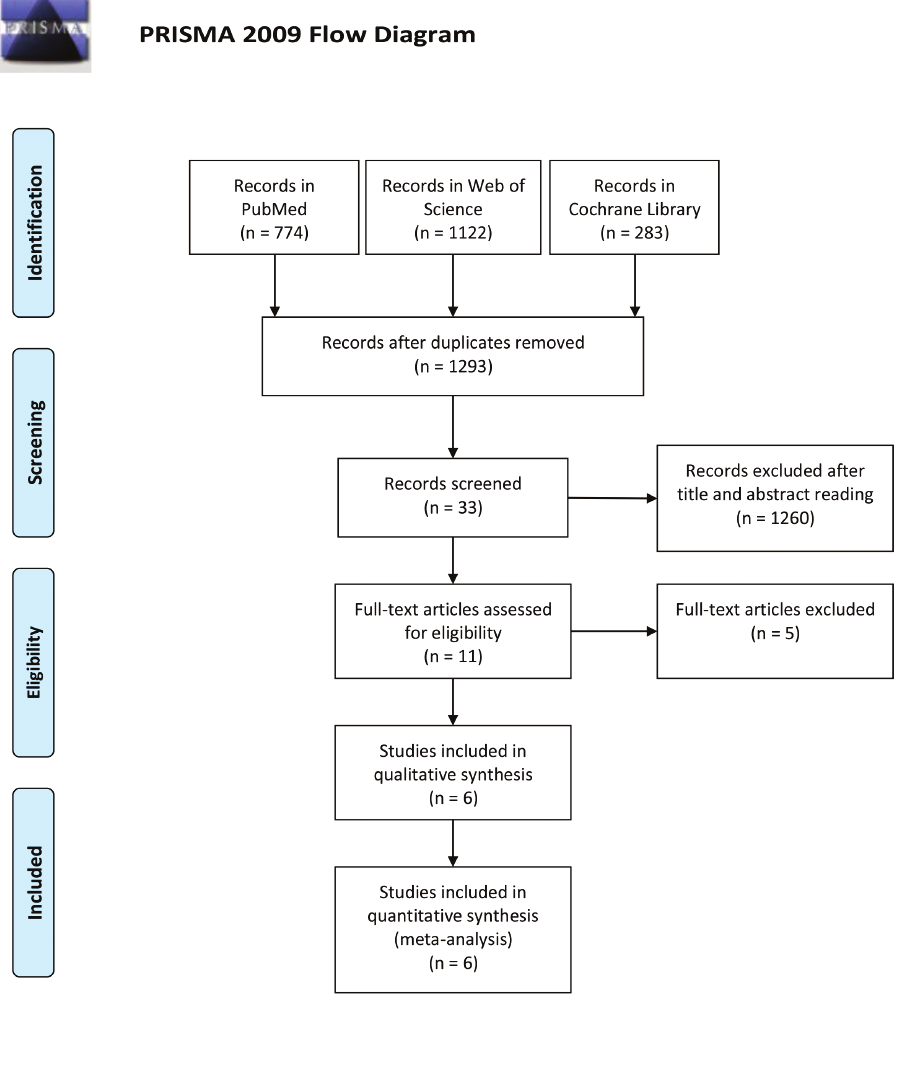
Figure 1: The study flow of the